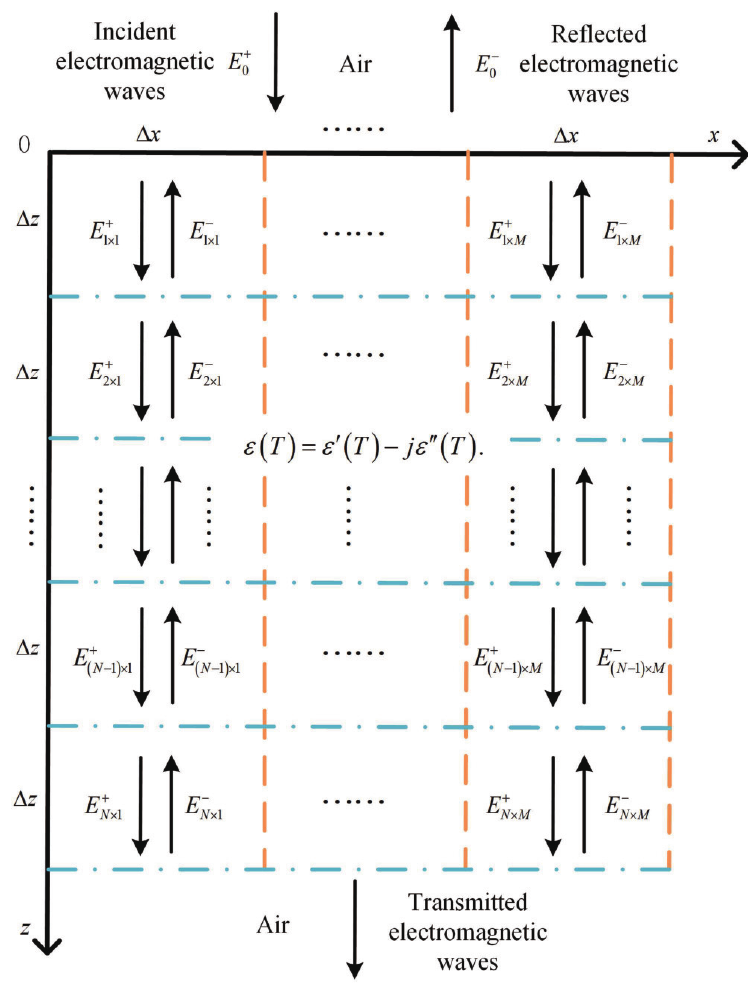
Figure 1. Meshing of the heated material. The medium was evenly divided into M equal parts along the x -axis, with each interval having a width of ∆ x . The medium was evenly divided along the z -axis into N equal parts, with each interval having a width of ∆ z . In each sufficiently small solution domain, the temperature is considered to be uniformly distributed. Based on the distribution characteristics of TE 10 mode, the electric field distribution in each small solution domain was first calculated in the z -axis direction; then, the sinusoidal distribution in the x -axis direction was computed; finally, the electric field distribution in each small solution domain was determined. To calculate the electric field strength E n × m in a small solution domain ( n rows and m columns), the electric field strength E n in the n th small solution domain along the z -axis was calculated and substituted into the following equation: